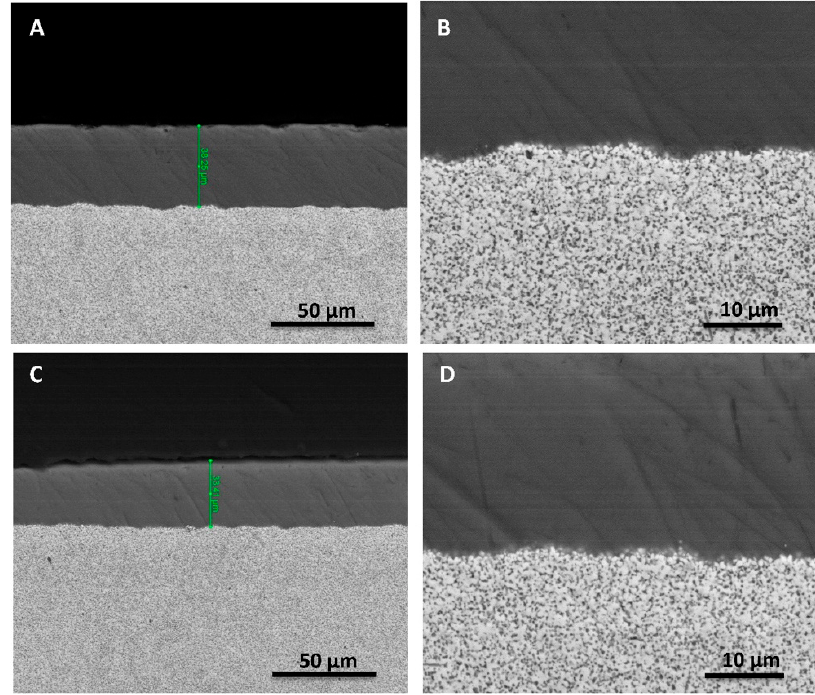
Figure 6. FESEM micrographs at different magnifications, showing the coating–substrate cross section. ( A , B ): Before the fatigue test. ( C , D ): After mechanical testing. No cracking is visible.